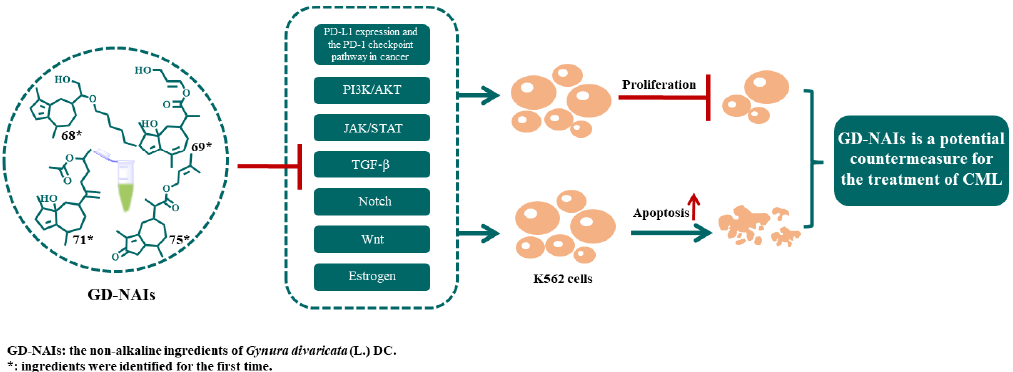
Figure 10. GD-NAIs exhibit anti-CML activity by targeting multiple pathways, including PD-L1 expression and the PD-1 checkpoint pathway in cancer, PI3K/AKT, JAK/STAT, TGF-β, estrogen, Notch and Wnt signaling pathways.